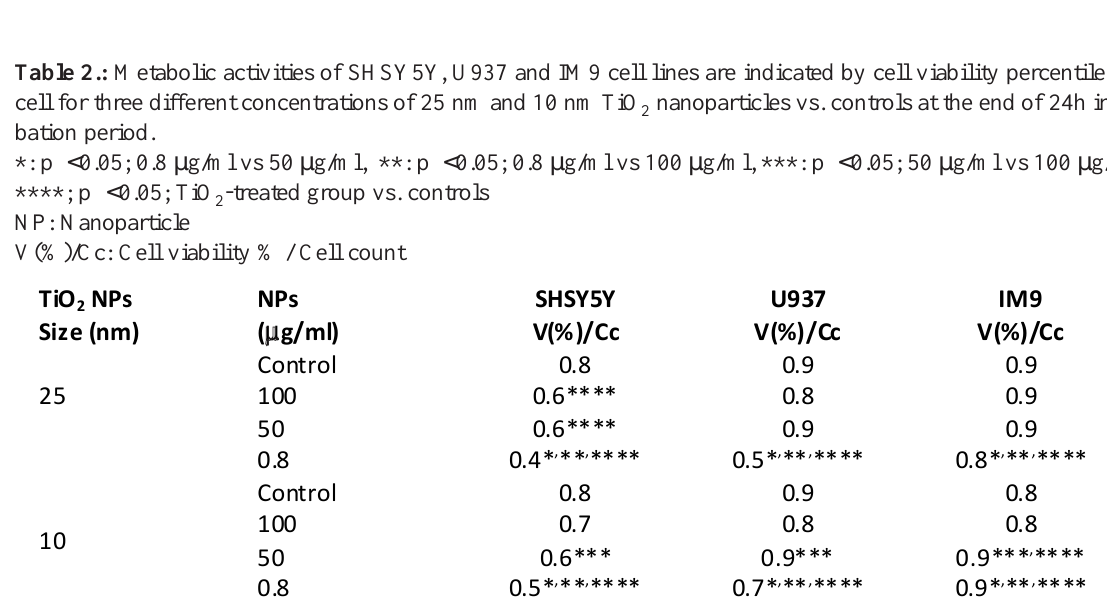
nanoparticles vs. controls at the end of 24h incu- 2